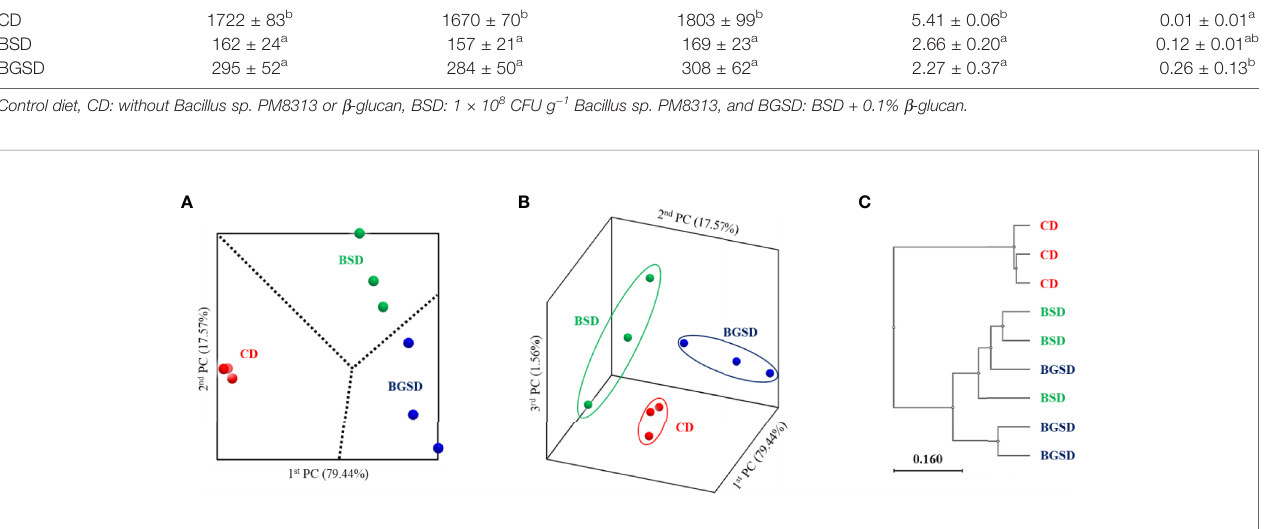
FIGURE 3 | Principal coordinate analysis based on the weighted UniFrac metrics (A, B) and unweighted pair group method with arithmetic mean tree (C) of bacterial operational taxonomic units between the different diets. Control diet, CD: without Bacillus sp. PM8313 or b -glucan, BSD: 1 × 10 8 CFU g − 1 Bacillus sp. PM8313, and BGSD: BSD + 0.1% b -glucan.